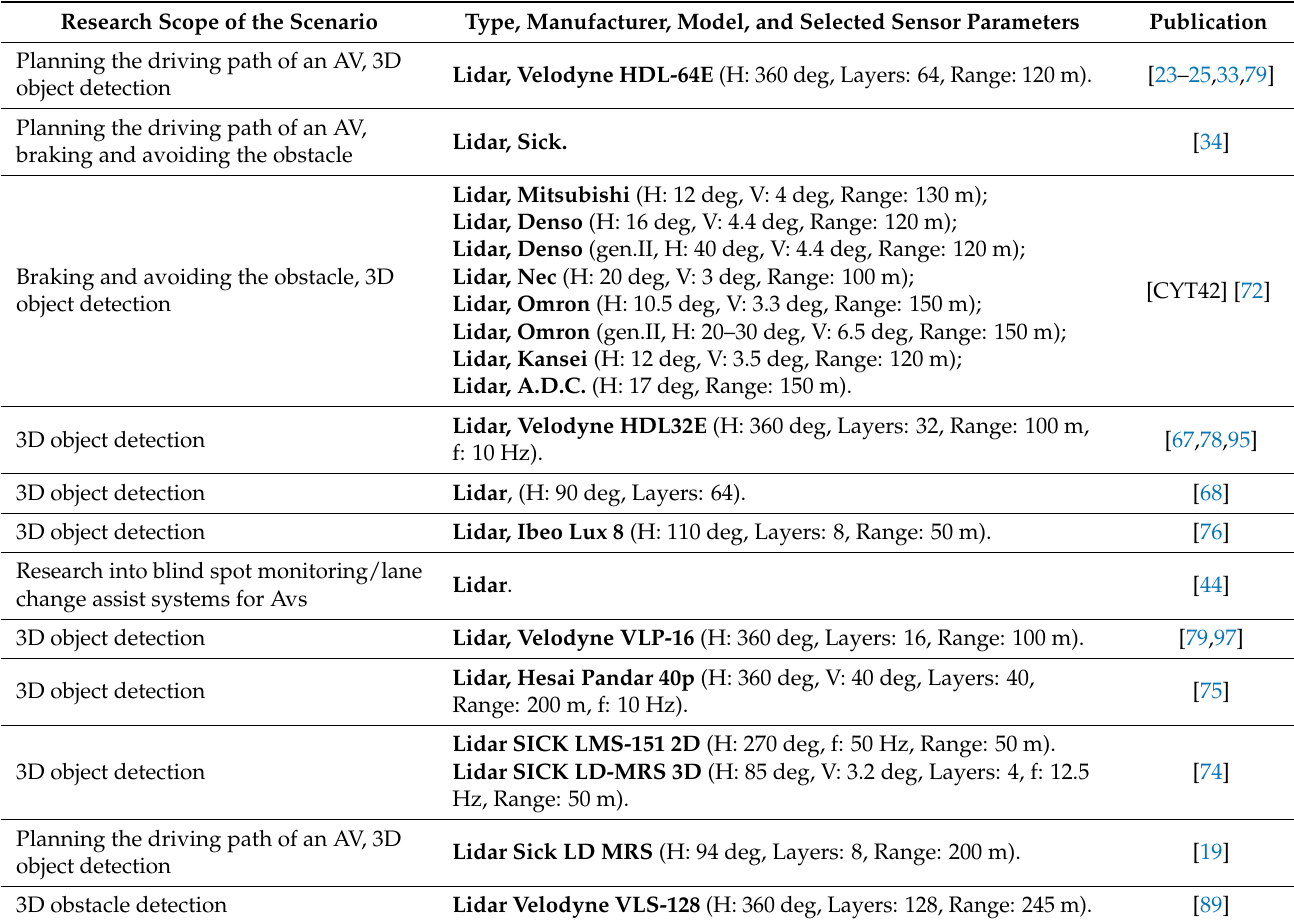
Table 9. Lidars used in perception and control systems during AV